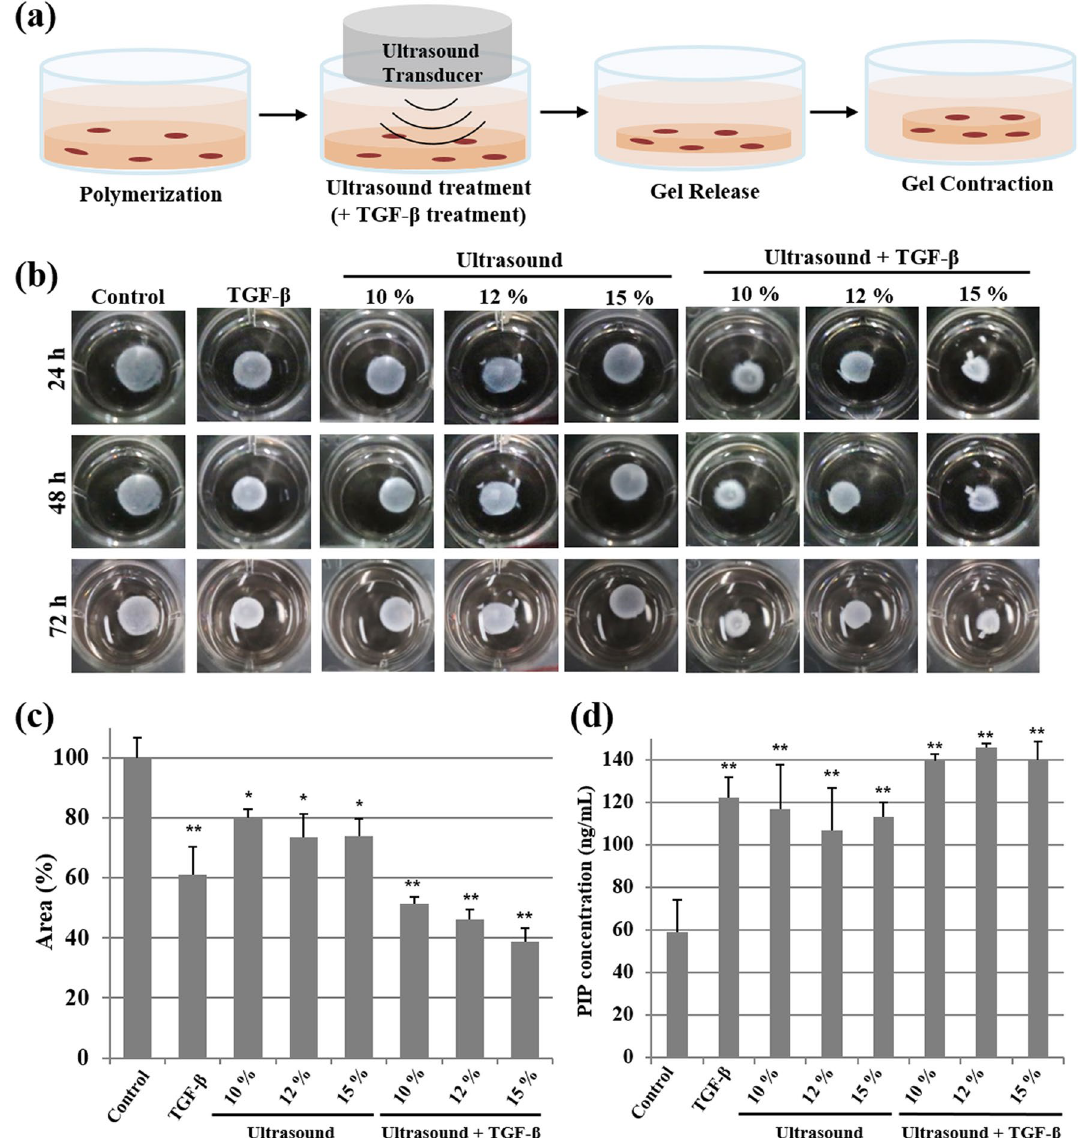
Figure 5. ( a ) Schematic illustration of the 3D collagen matrix contraction assay. Collagen matrices were treated with 10, 12, or 15% ultrasound for 10 s with or without TGF-β and then released. ( b ) Representative images of floating collagen matrices at 24, 48, and 72 h post-release were taken under optical microscopy. ( c ) Area of collagen matrix contracted at 72 h after treatment. ( d ) The levels of procollagen type I carboxyterminal peptide were determined in the media of the 3D collagen matrix at 72 h after each treatment using a specific PIP EIA kit. * P < 0.05, ** P < 0.01 compared with the control. All statistical analysis methods were one-way